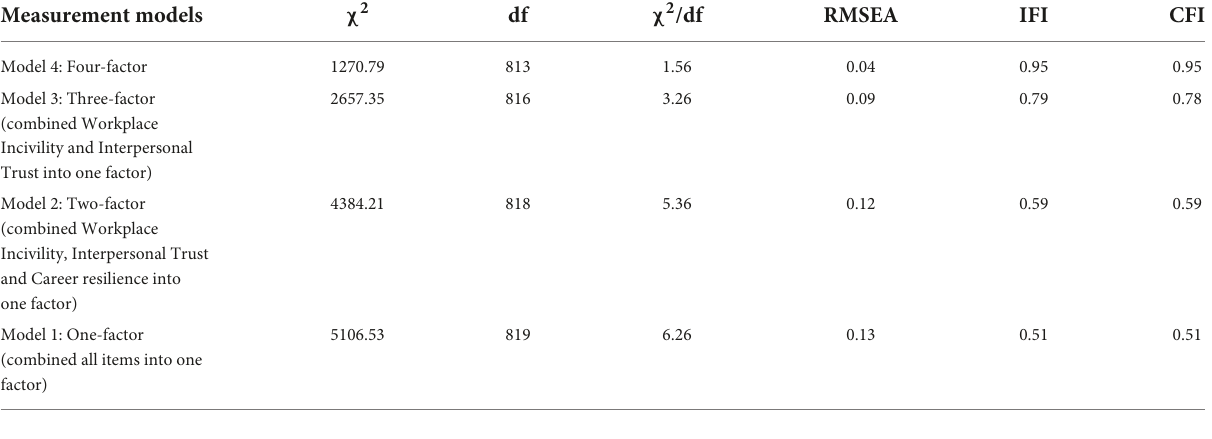
TABLE 2 Descriptive statistics and correlation analysis ( N = 315).